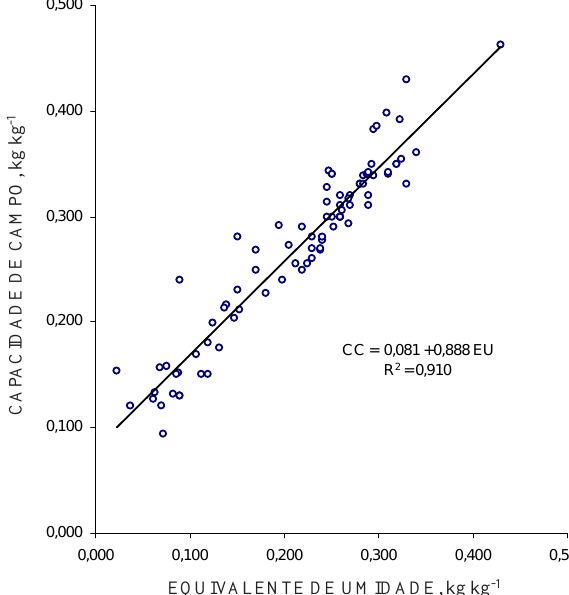
Figura 1. Relação entre a capacidade de campo e o equivalente de umidade para os Latossolos e Neossolos Quartzarênicos selecionados. O coeficiente da equação de regressão foi significativo a 1 % pelo teste